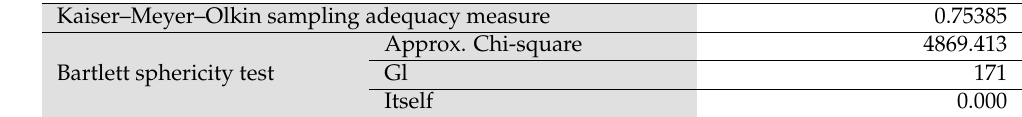
Table 4. KMO and Bartlett test.